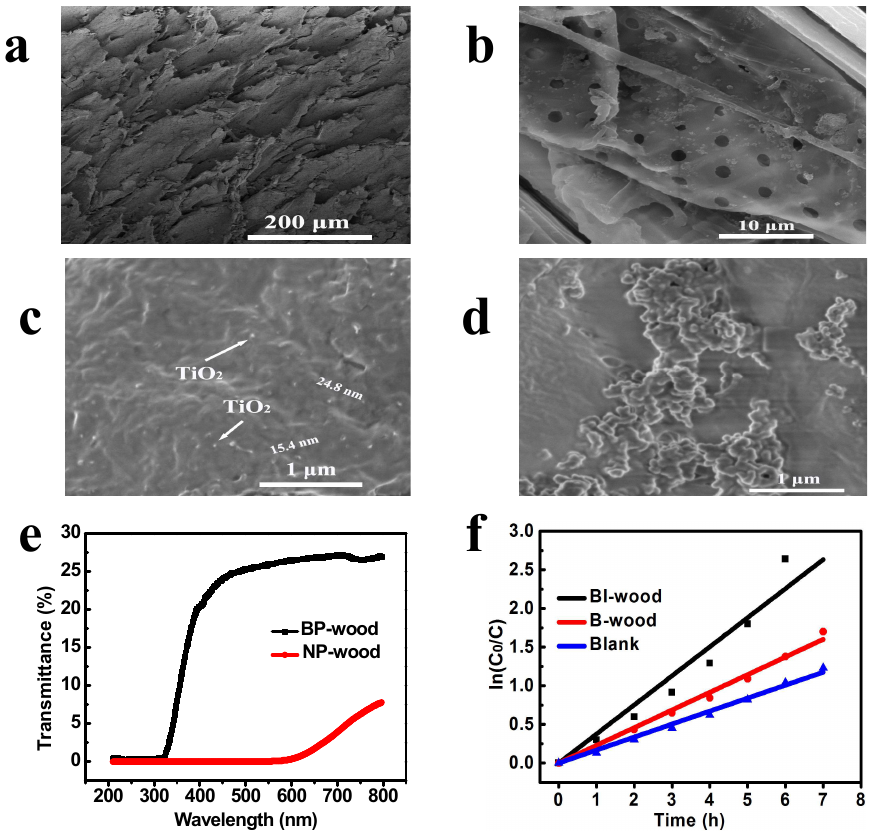
Figure 3. SEM images of B-wood’s ( a ) top surface and ( b – d ) cross section decorated with P25 nanoparticles. ( e ) Optical transmittance of BP-wood and NP-wood. ( f ) Comparison of photocatalytic degradation of BI-wood with TiO 2 removed at the top and B-wood and blank control groups (where C 0 is the initial concentration of the dye solution and C is the concentration of dye at corresponding time) [6].